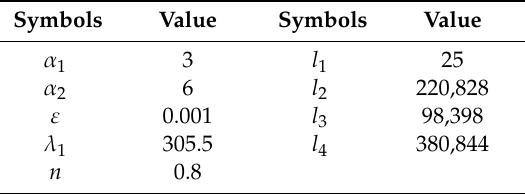
Table 4. Gains of two observers.